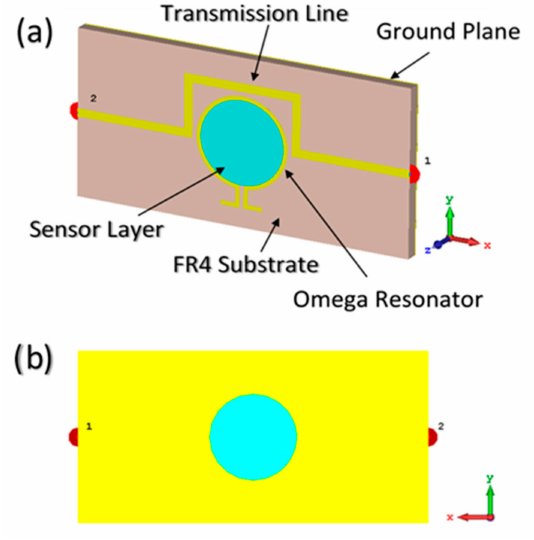
Figure 1. Proposed metamaterial-based liquid sensor design: ( a ) perspective view; ( b ) back